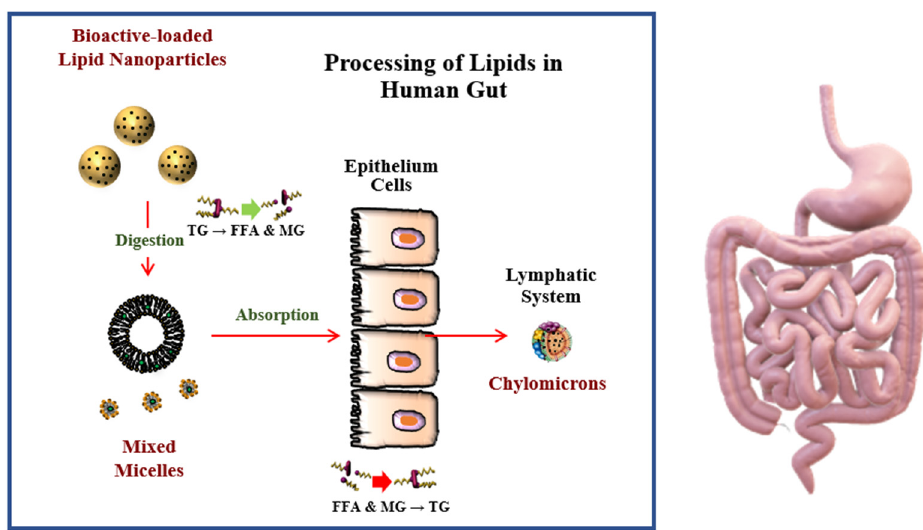
Figure 4. The bioavailability of hydrophobic bioactive substances can be increased by encapsulating them in nanoparticles. The triglycerides (TG) in the lipid nanoparticles are broken down to free fatty acids (FFA) and monoglycerides (MG), which are packed into mixed micelles with bioactive substances and transported to the epithelium cells. They are then reassembled into triglycerides, packed into chylomicrons, and transported into the bloodstream through the lymphatic system. Lipid digestion and nutraceutical bioaccessibility increases with decreasing droplet size.